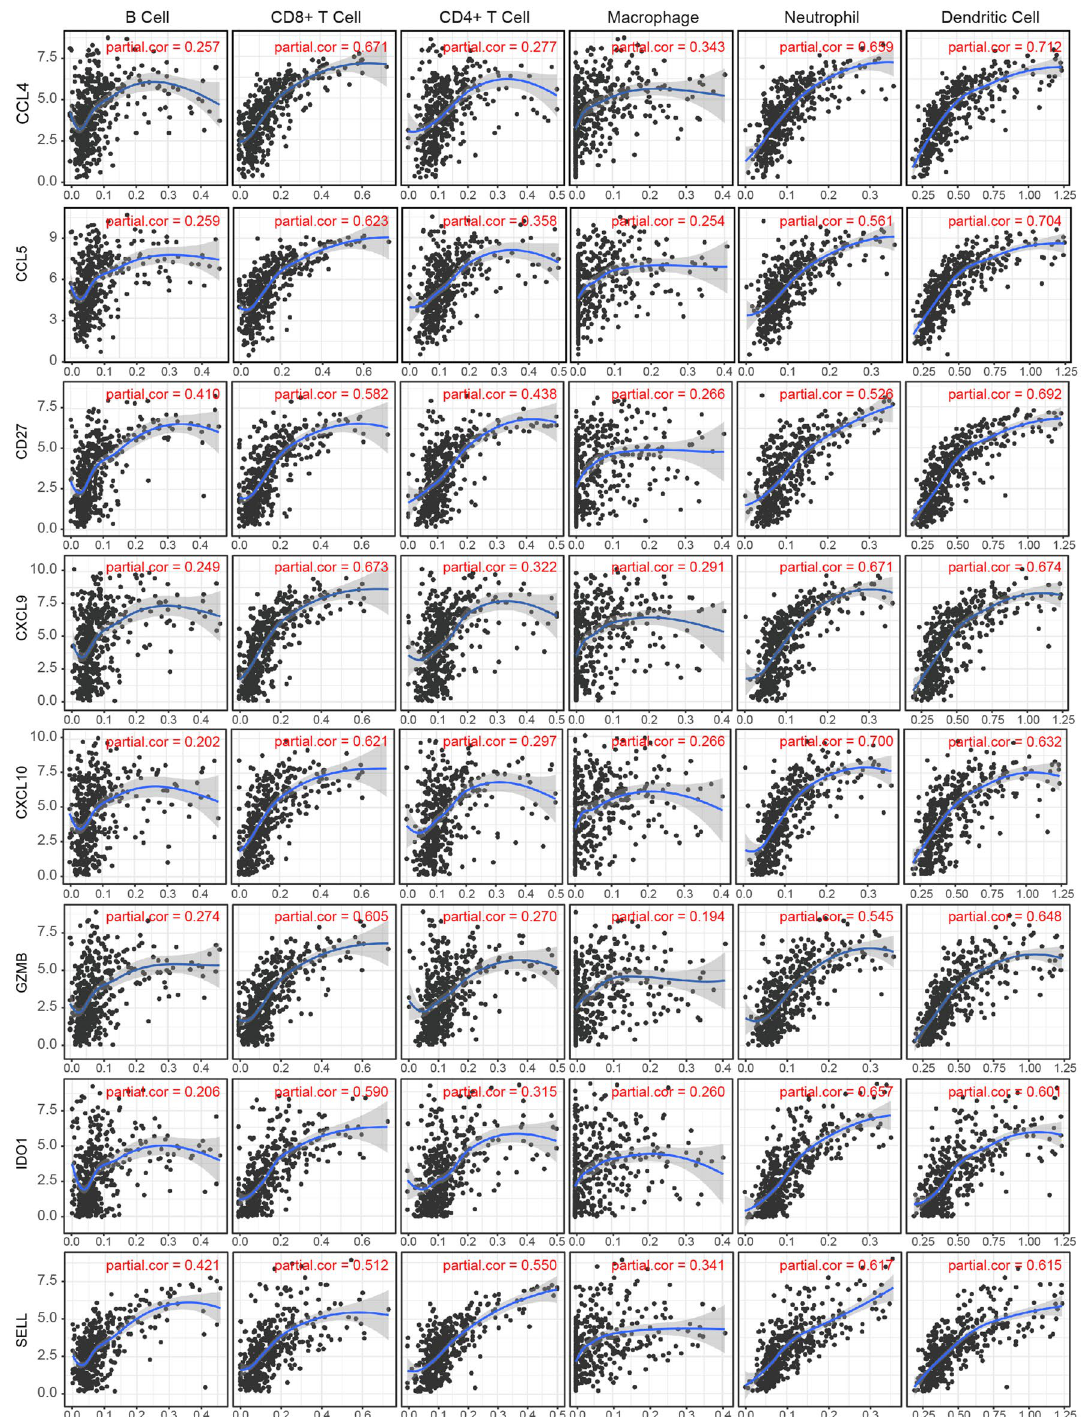
Figure 6. The correlation between hub genes and immune cell infiltration. The expression of hub genes was positively correlated with the infiltration level of CD8 + T cells, DCs and neutrophils (Cor > 0.5). In addition, SELL was also positively correlated with the infiltration level of CD4 + T cells. Three other immune cells (B cells, macrophages, CD4 + T cells) were also positively associated with these hub